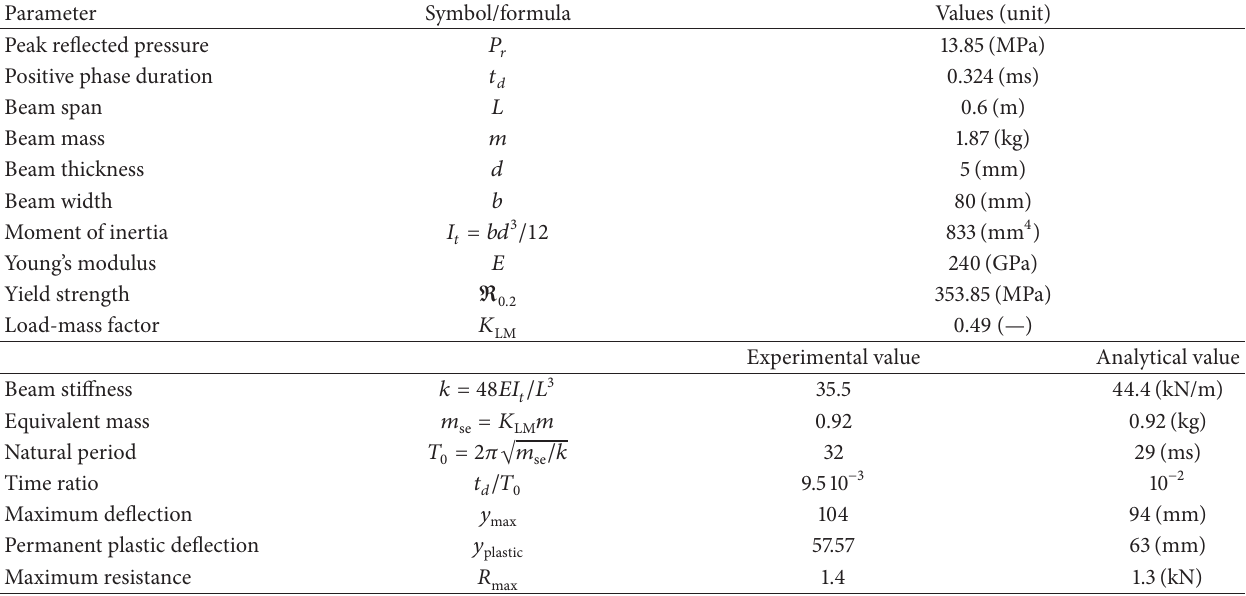
Table 3: Loading parameters and dynamic properties for an elastic-plastic, simply supported beam.